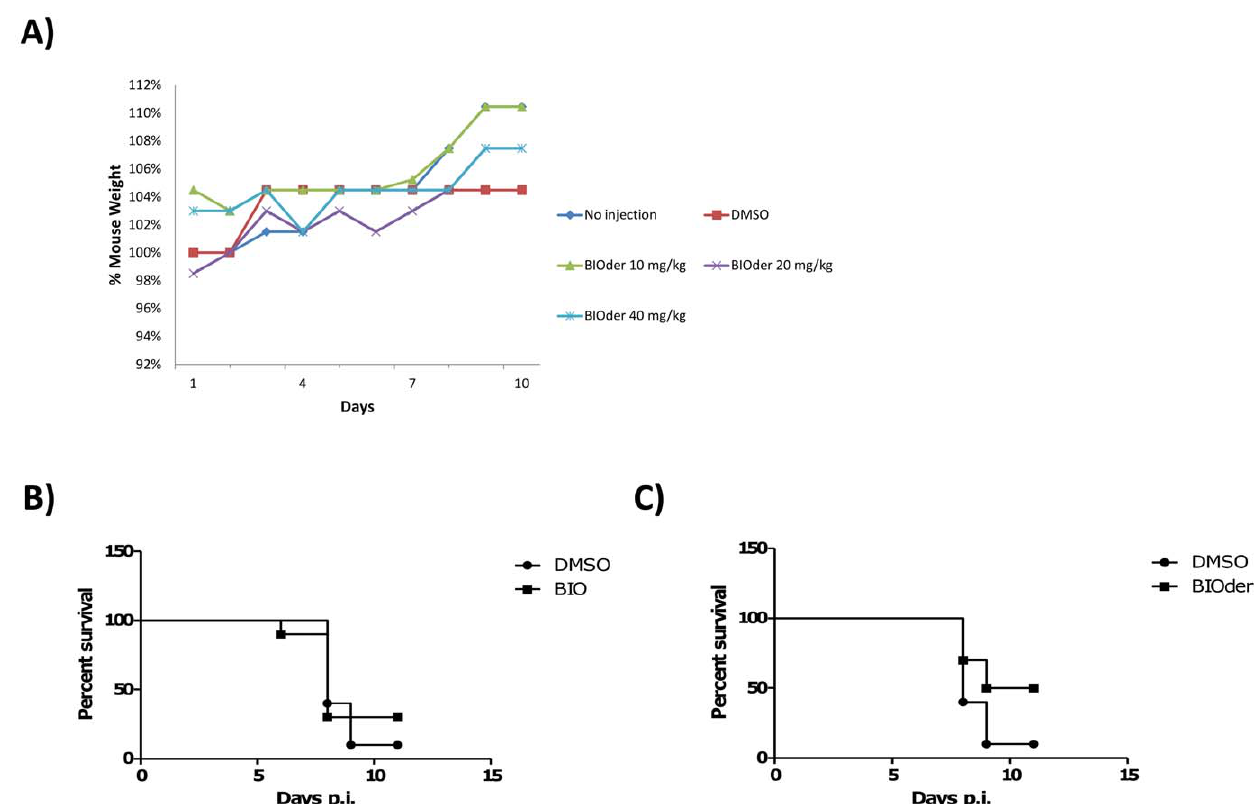
Figure 7. BIOder inhibits VEEV cell death invivo . A ) Female C3H/HeN mice were treated subcutaneously with either DMSO or various concentration of BIOder (10 mg/kg, 20 mg/kg, 40 mg/kg) every day for 5 days. Mice were weighed daily and the average % of the mouse weight is plotted in panel A. B ) and C ) Female C3H/HeN mice were infected intranasally with 5 6 LD50 (2 6 10 7 pfu) of VEEV TC-83. Groups of 10 mice were treated SQ with vehicle, BIO (50 mg/kg) or BIOder (20 mg/kg) on days 2 1, 1, 3, and 5 and were monitored for survival for 14 days. Kaplan-Meier curves for survival between DMSO and BIO (panel B). Kaplan-Meier curves for survival between DMSO and BIOder (panel C). Significance was determined using Mantel-Cox Log-rank test. P-value of 0.057 between control and BIOder. This experiment was performed one time.